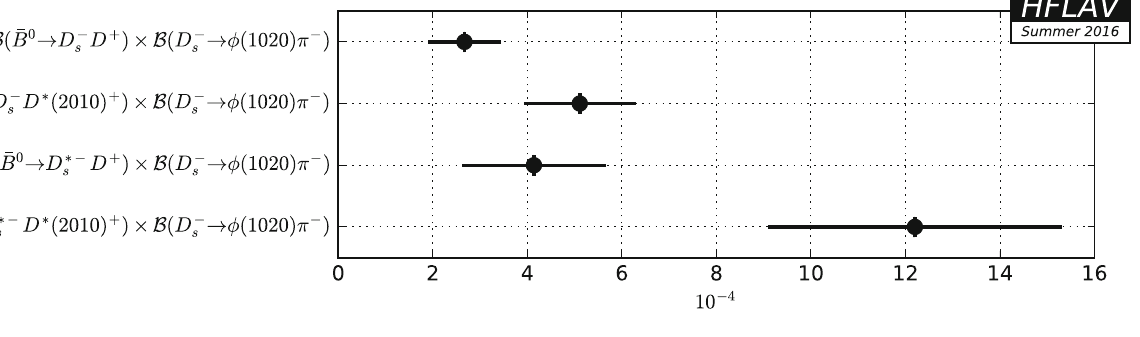
Fig. 85 Summary of the averages from Table 110